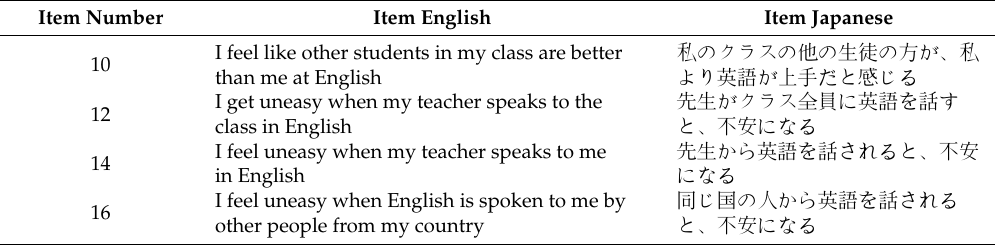
Table A3. Anxiety.